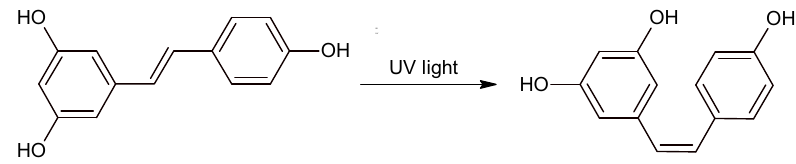
Figure 1. trans -RSV to cis -RSV isomerization induced by UV light.